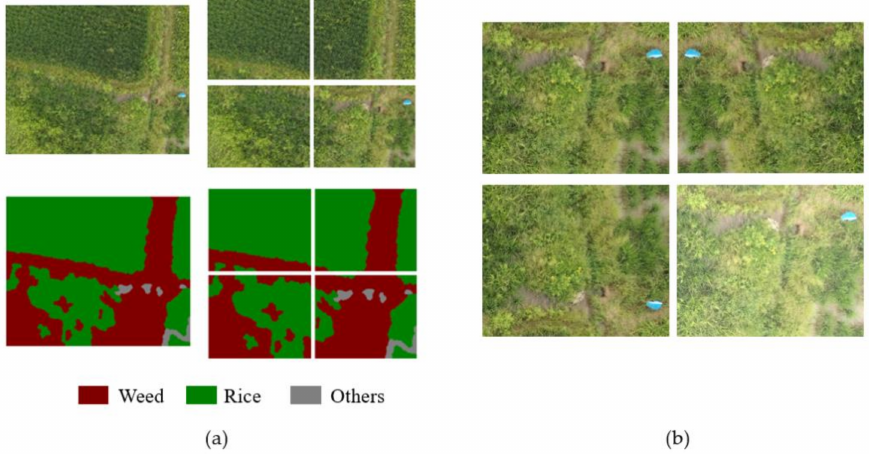
Figure 4. Image clipping and data enhancement. ( a ) Image clipping; ( b ) Data